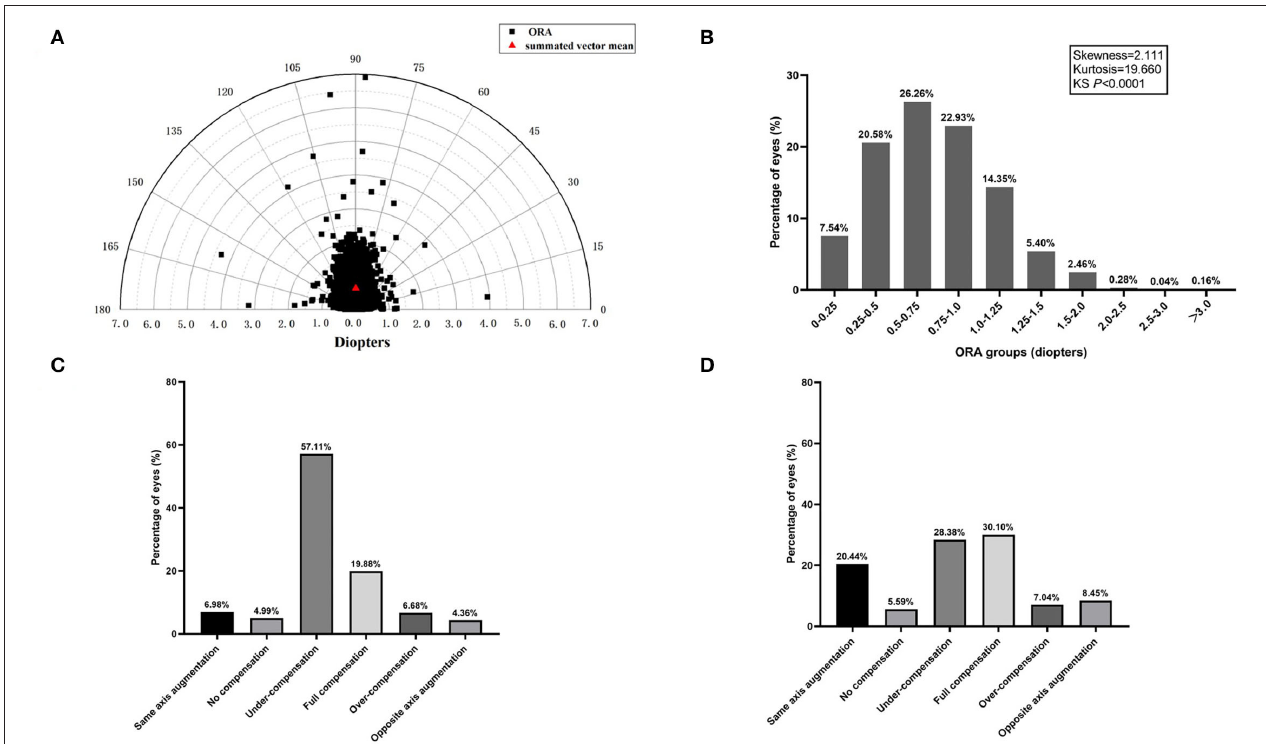
FIGURE 1 | (A) The distribution of ocular residual astigmatism (ORA) magnitude and orientation is shown as a polar diagram. (B) Frequency distribution of ORA magnitude. (C) Percentages of anterior corneal astigmatism (ACA) compensation by ORA in J 0 . (D) Percentages of ACA compensation by ORA in J 45 .